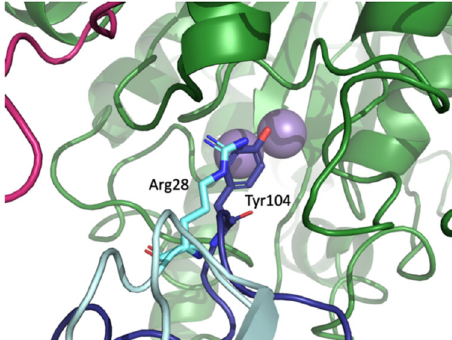
Fig. 6 Comparison of mAbs 1-3 and mAb4 epitopes. A closeup view of the hArg1 active site reveals the differences in epitopes between mAbs 1-3 and mAb4. The CDR-3 HC Tyr104 of mAbs1-3 (dark blue) is replaced by the CDR-1 LC Arg28 in mAb4 (cyan). In both cases the hArg1 active site is completely blocked by the Methods Expression and puri fi cation of hArg1 . Full-length untagged hArg1 was expressed in E.coli BL21 (DE3) using superbroth media. Expression was induced with 1 mM